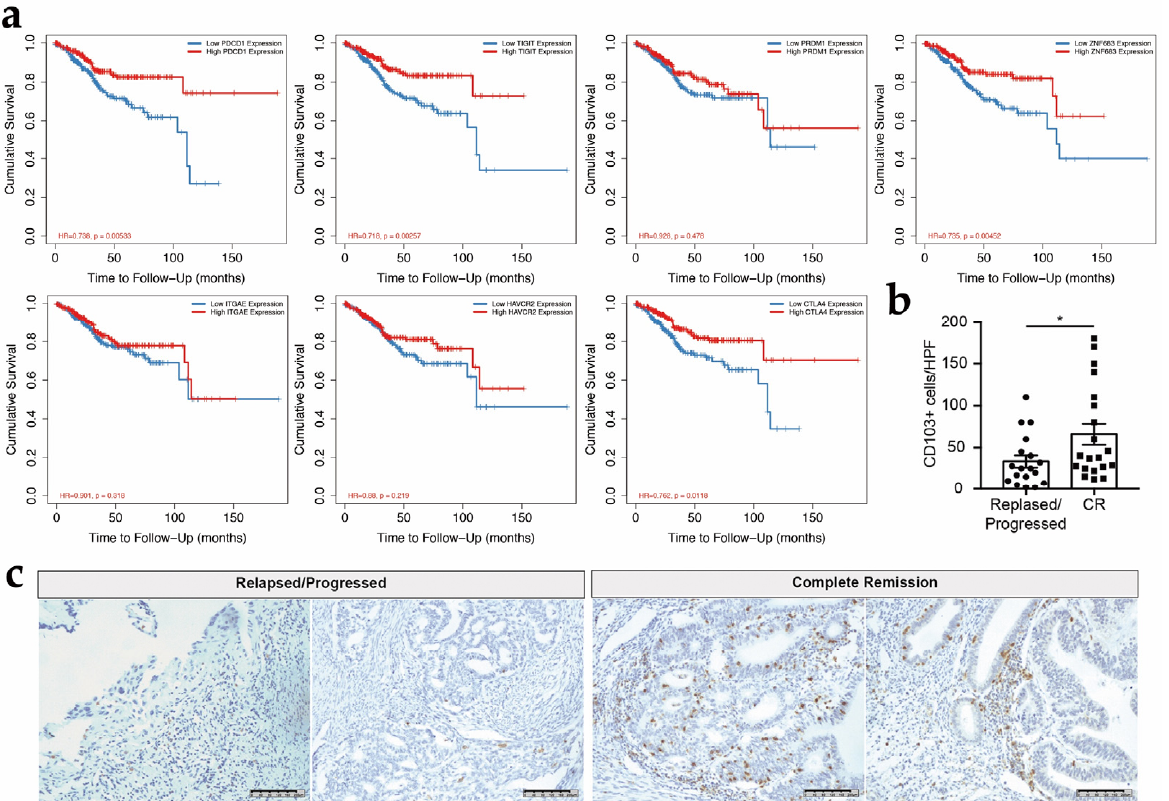
Figure 7. CD103+ CD8+ T cells are associated with a better prognosis for patients with EC. ( a ) Survival analysis shows that high expressions of ZNF683, PRDM1, ITGAE, PDCD1, TIGIT, and CTLA-4 correlate with an improved prognosis. ( b ) The CD103+ cell density is correlated with patient prognosis. CR: complete remission. ( c ) Representative images of immunohistochemical staining of EC tissues from patients who had achieved complete remission for 5 years or relapsed. The data are presented as the means ± SEM from 18 to 20 individuals per group. The p value was obtained from the comparison of the indicated groups using an unpaired t test (two-tailed). p < 0.05 (*).